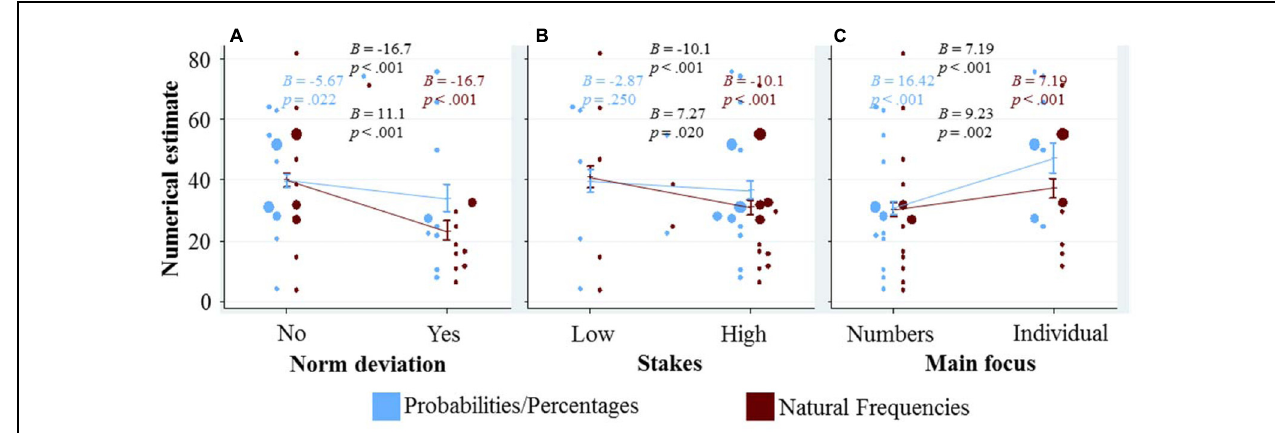
FIGURE 3 | Graphical exploration of how the qualitative variables (displayed at the x-axes) affect the numerical estimates (displayed at the y-axis). To avoid overlap of the dots (see the caption of Figure 2 for details what they represent), the blue dots are displayed slightly to the left of the confidence interval for the marginal effect, and the red dots slightly to the right. In addition, blue (red) dots that would overlap with other blue (red) dots are moved